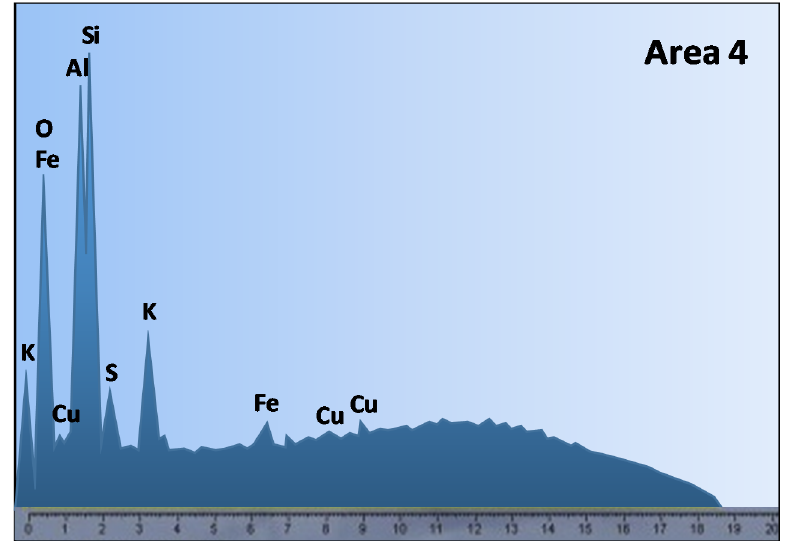
Figure 3. EDS microanalysis of areas indicated in the SEM (Modified from [51]).